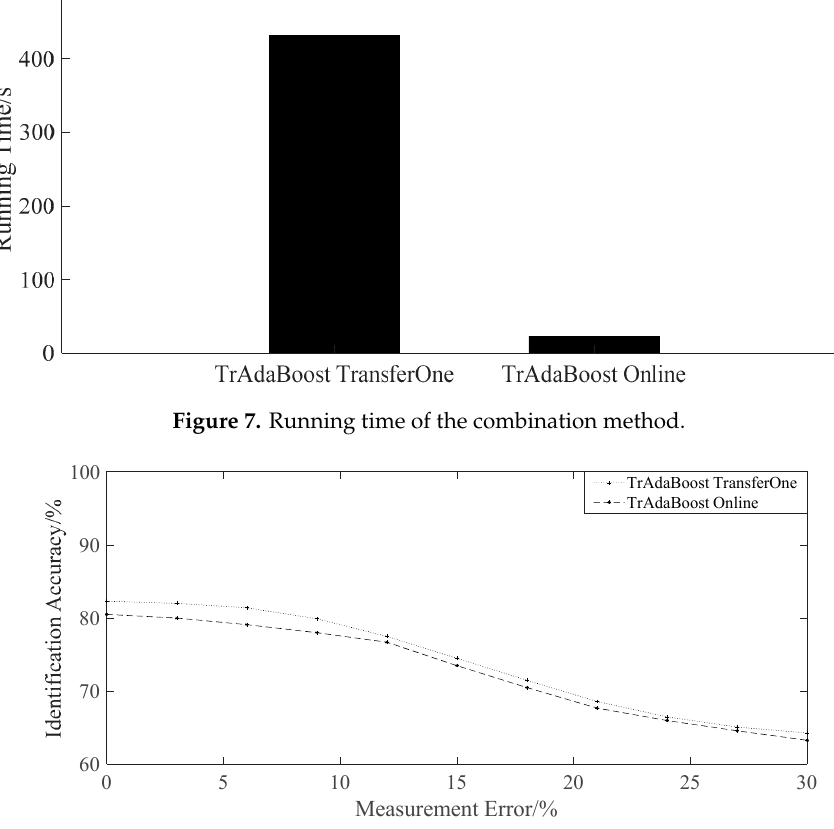
Figure 8. Identification accuracy of the combination method.